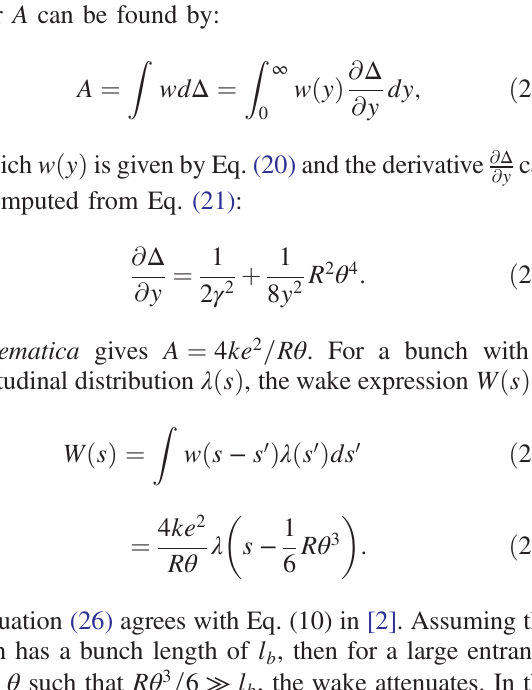
1 γ R θ 2 . p ¼ 2